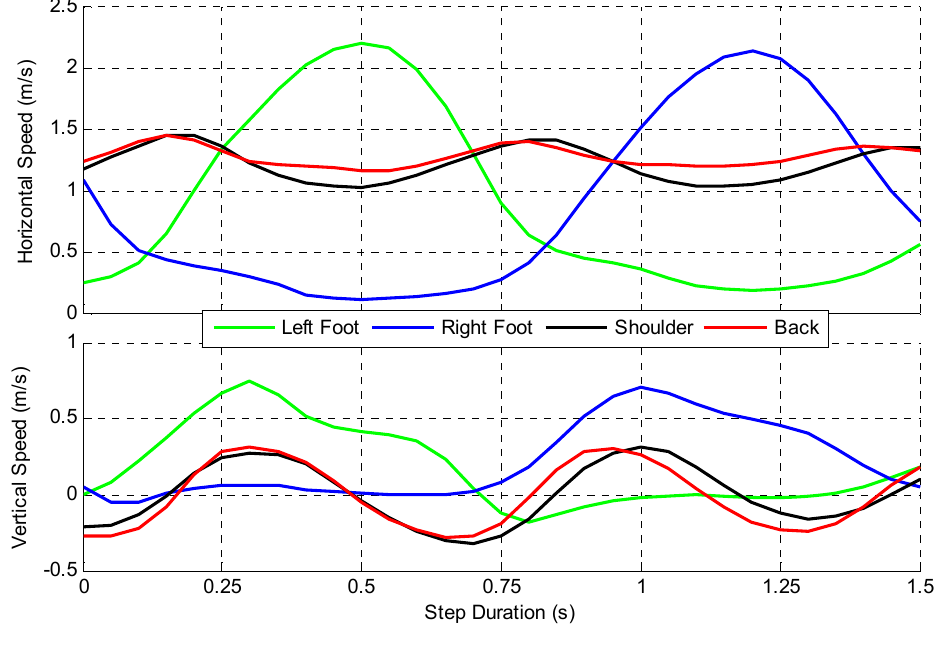
Figure 11. Hiker’s Average Velocity at Various Sensor Locations during each